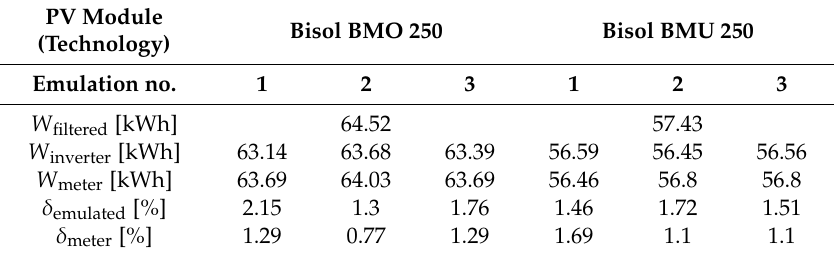
Table 9. Results of fast PV power emulation of the 12 kW PV plant for 4 June 2017.